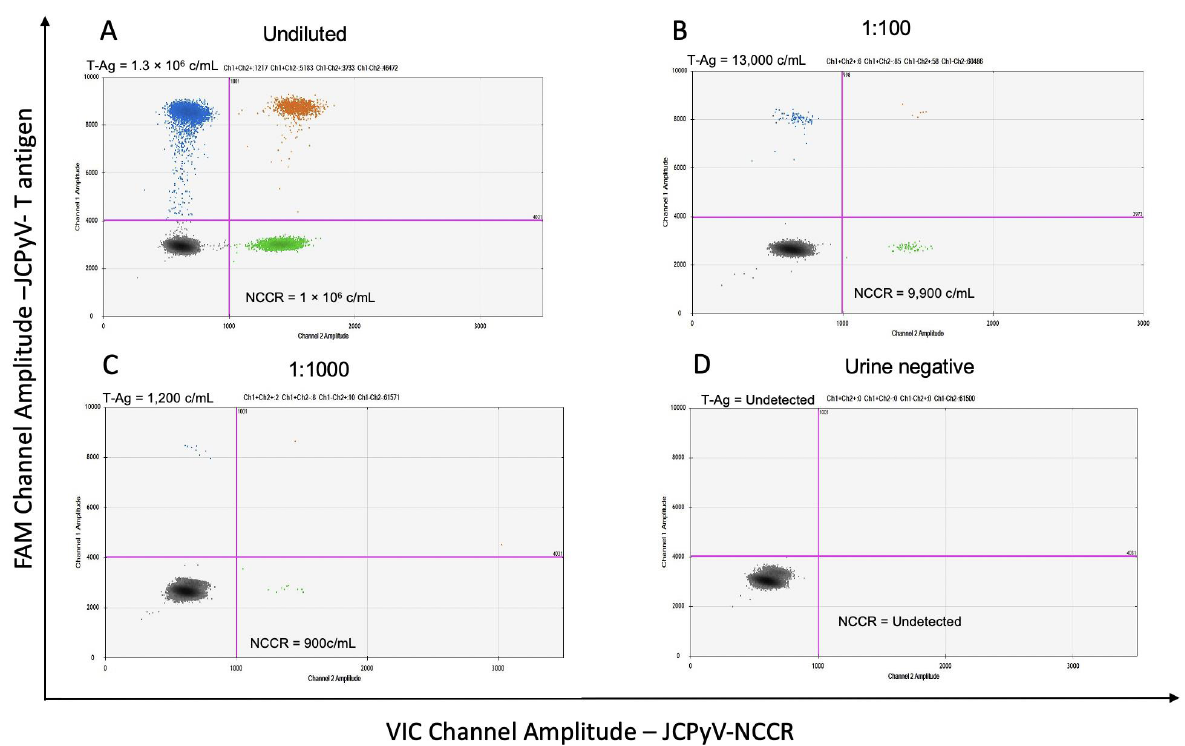
Figure 1. Representative two-dimensional ddPCR plots of a PML urine sample at different serial dilutions. ( A ) Urine DNA undiluted displays both JCPyV-large T-Ag and a sequence in the NCCR of the archetype at similar copies number value demonstrating the presence of only the non-virulent variant. ( B,C ) are serial dilutions of the same clinical samples. ( D ) No JCPyV genomes were detected in the urine sample of another PML patient.